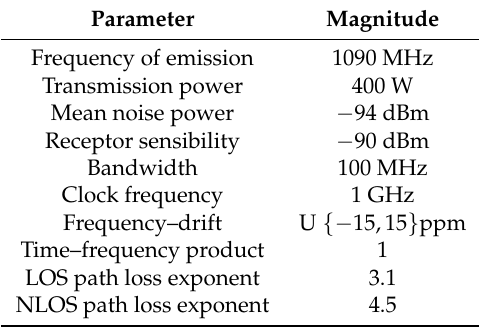
Table 1. Asynchronous Time Difference of Arrival (A-TDOA) parameter configuration for the simulations, whose selection is based on